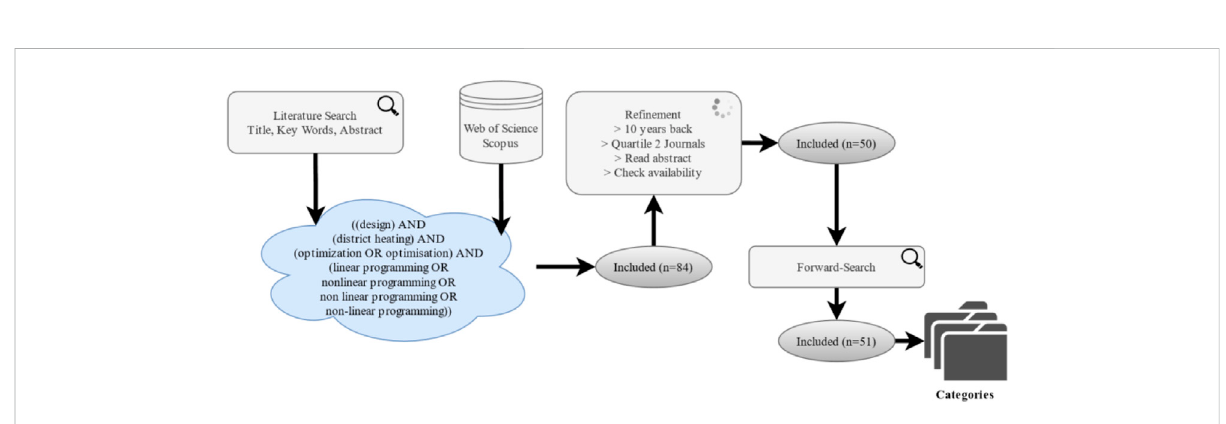
FIGURE 2 Summary of the methodology for the systematic literature